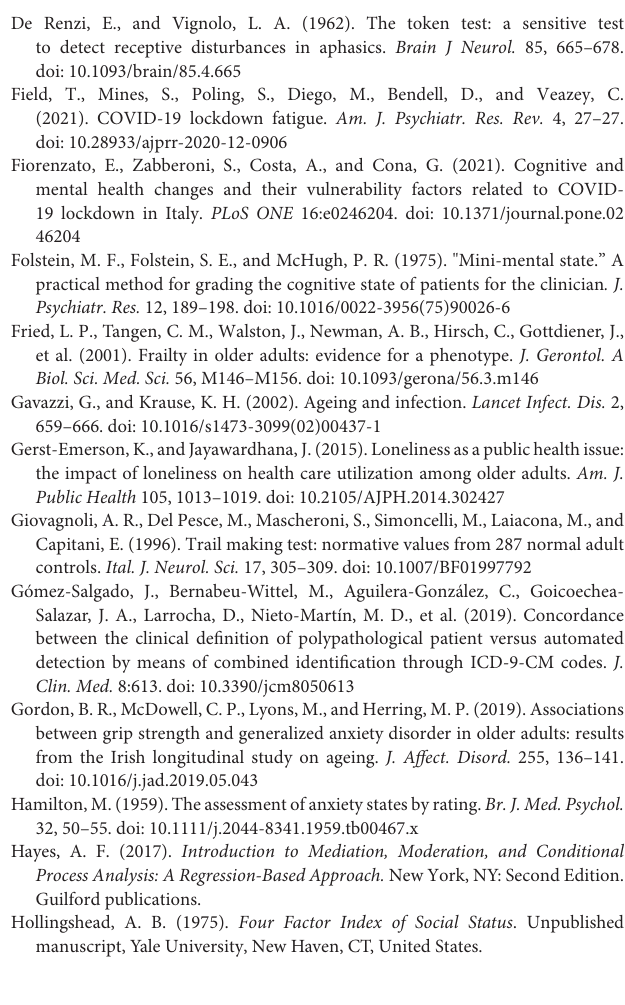
Supplementary Figure 1 | The moderate-mediation model, adapted from Hayes’ model 7 (page 588). BDI, Beck Depression Inventory; TMT-A, Trail Making Test- Part A; LFS, Lockdown Fatigue